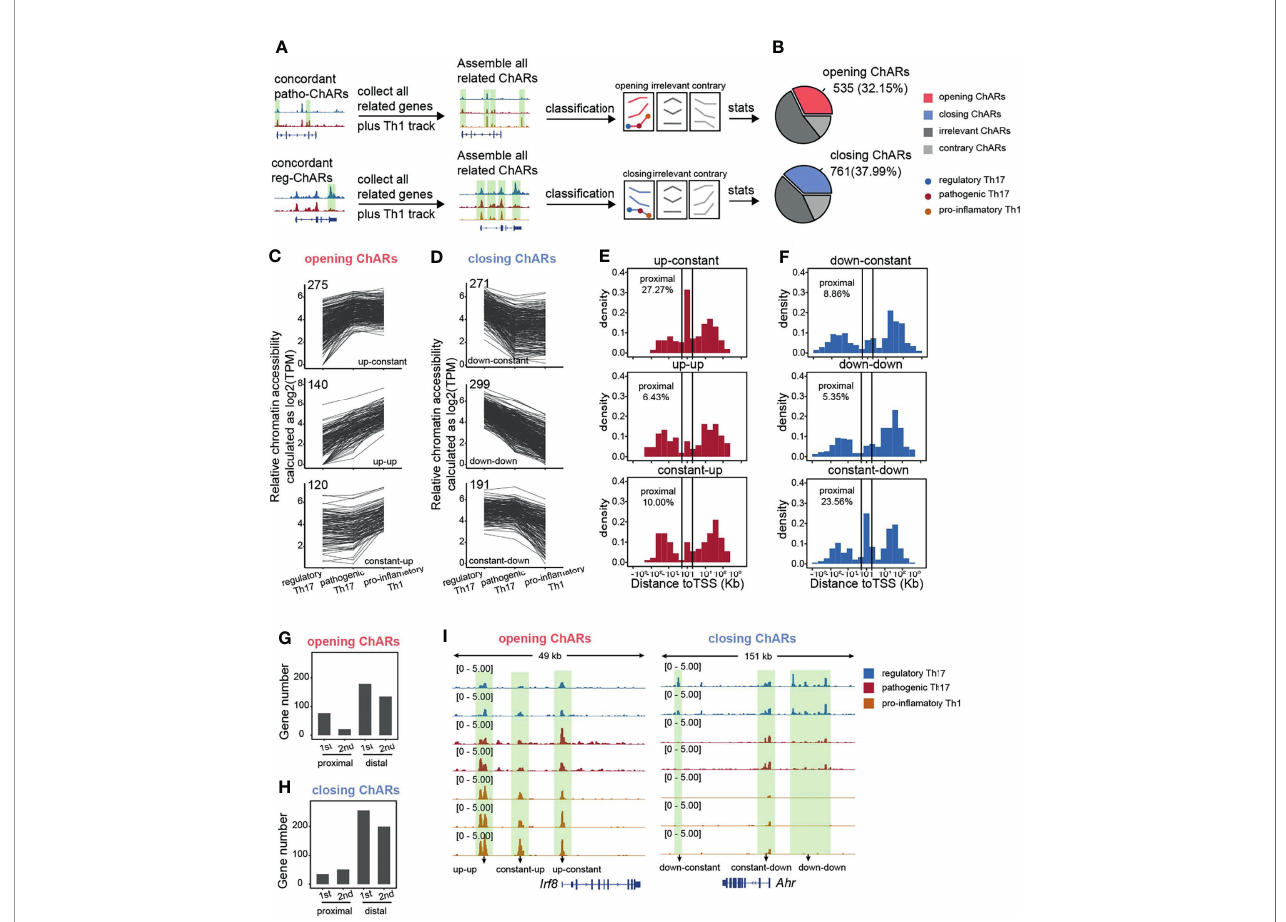
FIGURE 3 | Gene loci related to concordant patho-ChARs are sequentially opened from TSS-proximal region to TSS-distal region during Th17 to Th1 conversion. (A) Work fl ow of identifying all ChARs associated with patho-ChAR or reg-ChARs related genes. (B) Statistics of opening ChARs and closing ChARs during the regulatory Th17 to pathogenic Th17 conversion. Opening ChARs and closing ChARs, display concordant accessibility changes (fold change >1.5) in at least one step of the conversion, and never show any contrary changes; contrary ChARs, display contrary accessibility changes (fold change >1.5) in at least one step of the conversion; irrelevant ChARs, the residual ChARs. (C) Line plots of opening ChARs with ‘ up-constant ’ , ‘ up-up ’ , and ‘ constant-up ’ modes. (D) Line plots of closing ChARs with ‘ down-constant ’ , ‘ down-down ’ , and ‘ constant-down ’ modes. (E) Distance of opening-ChARs with ‘ up-constant ’ , ‘ up-up ’ , ‘ constant-up ’ modes to their neighboring TSSs, respectively. Percentage of ChARs found within +1 to -1 Kb of TSS were calculated. (F) Distance of closing-ChARs with ‘ down-constant ’ , ‘ down- down ’ , and ‘ constant-down ’ modes to their neighboring TSSs, respectively. Percentage of ChARs found within +1 to -1 Kb of TSS were calculated. (G) Counting for the numbers of genes related to opening-ChAR changes in TSS-proximal or TSS-distal regions in two steps of the Th17 to Th1 conversion. 1 st , regulatory Th17 to pathogenic Th17 conversion; 2 nd , pathogenic Th17 to pro-in fl ammatory Th1 conversion. (H) Counting for the numbers of genes related to closing-ChAR changes in TSS-proximal or TSS-distal regions in two steps of the Th17 to Th1 conversion. 1 st , regulatory Th17 to pathogenic Th17 conversion; 2 nd , pathogenic Th17 to pro- in fl ammatory Th1 conversion. (I) ATAC-Seq tracks at Irf8 (particular opening-ChAR related gene) and Ahr (particular closing-ChAR related gene) loci, with differential peaks highlighted in